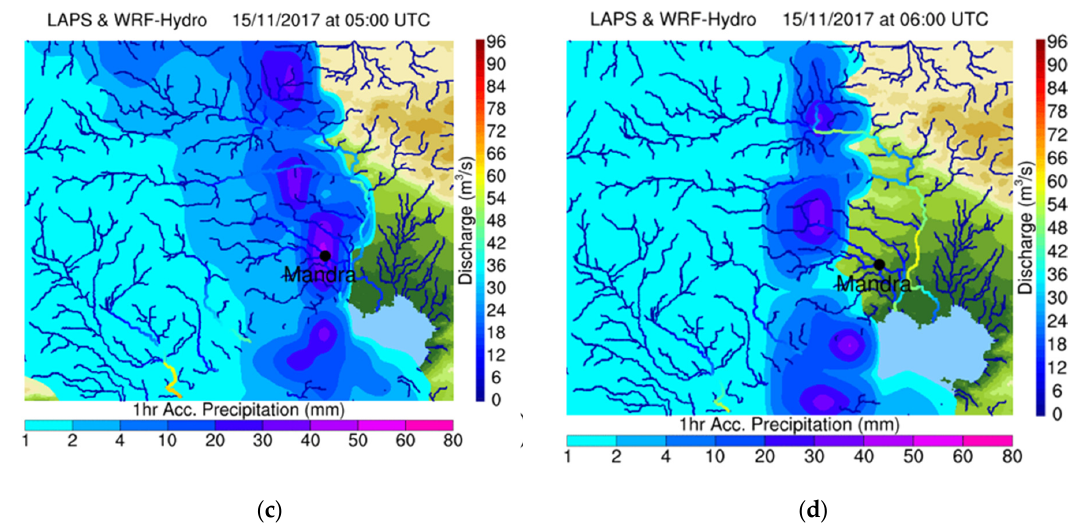
Figure 5 . One hour accumulated precipitation superimposed with the simulated discharges forced by the LAPS nowcasts. WRF-Hydro simulation starting on 15 November at 02:00 UTC and going up to 06:00 UTC every hour ( a – d ), forced by LAPS nowcasts from 03:00 to 06:00 UTC. Streams with order 4 or higher are presented.